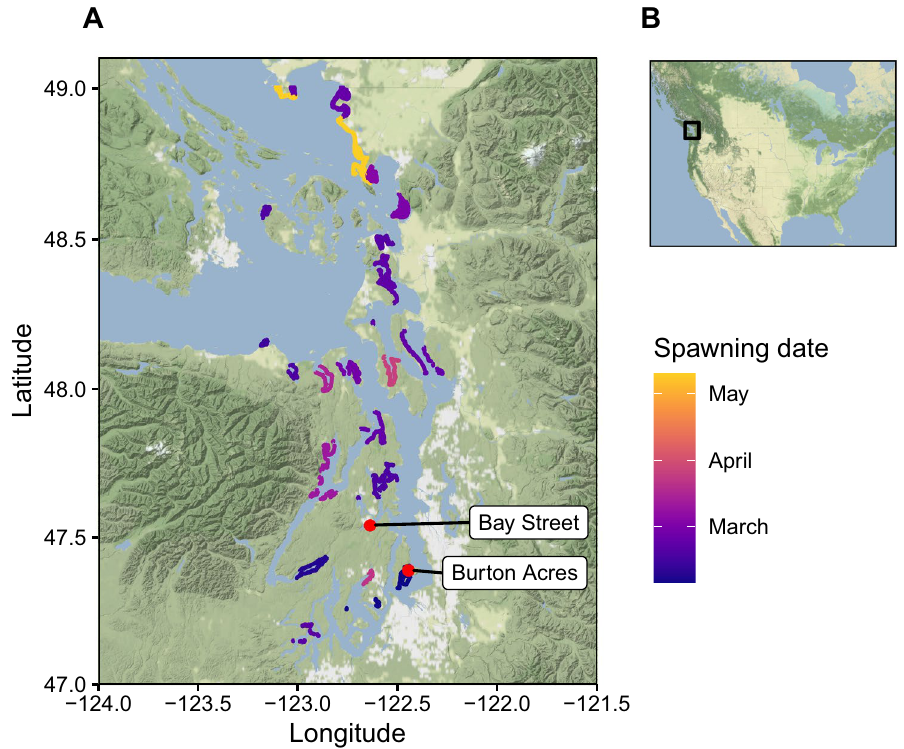
Figure 1. Map of archaeological sites (red points) in relation to contemporary herring spawning locations in Puget Sound. Spawning locations in Washington State are depicted by lines whose color represents the average spawning date, estimated using multidecadal spawn survey data 17